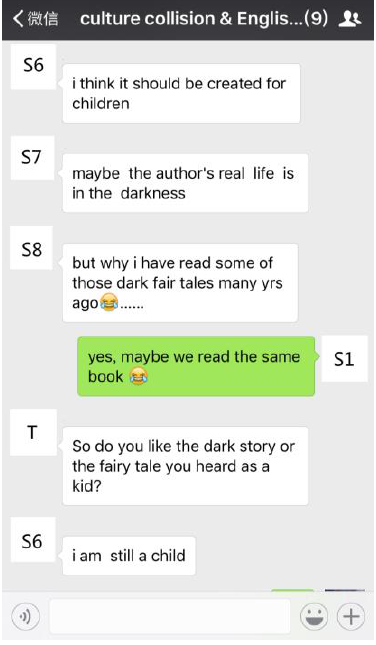
Figure 2-B. Discussion about fairy tales